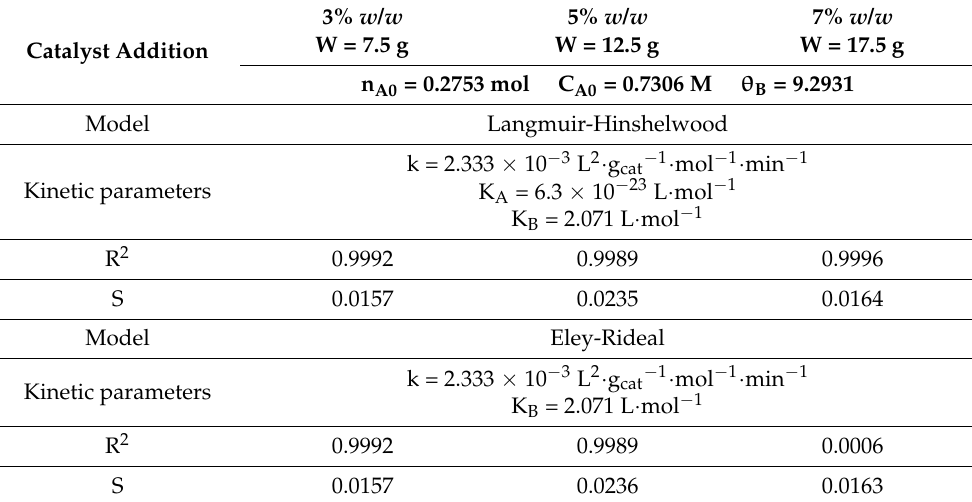
Table 6. Kinetic parameters for LH and ER models for different catalyst additions. Experimental conditions: methanol/oil ratio, 9:1; temperature, 65 ◦ C; stirring rate, 700 rpm.